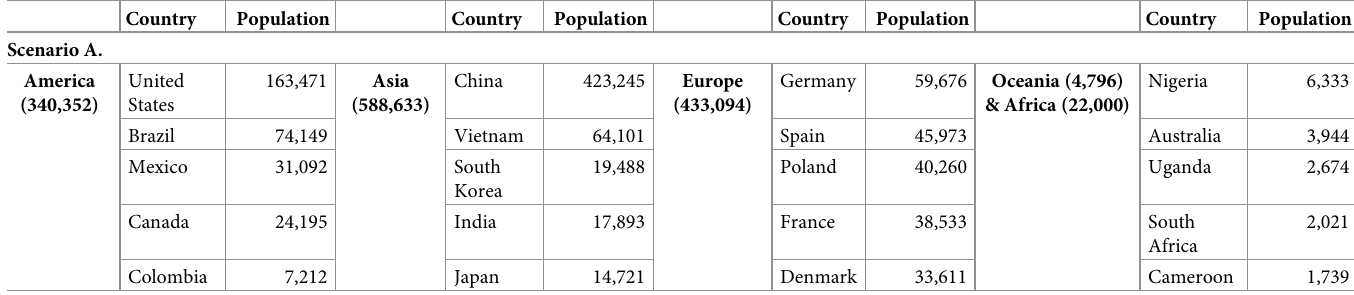
Table 2. The domestic pig population (thousands) exist in the predicted potential risk areas for African swine fever within each continent and the top five countries contributing to these population at risk.